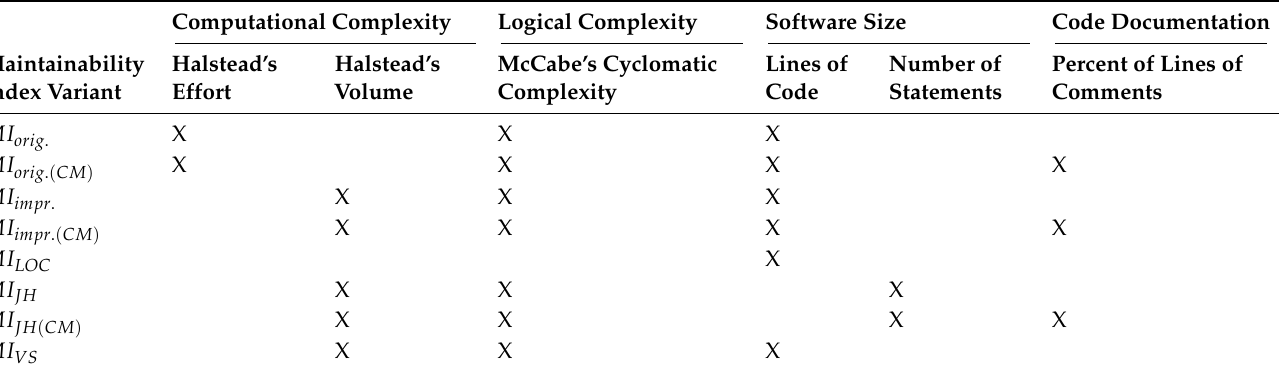
Table 1. The inclusion of software metrics for the computation of Index variants and software aspects the metrics